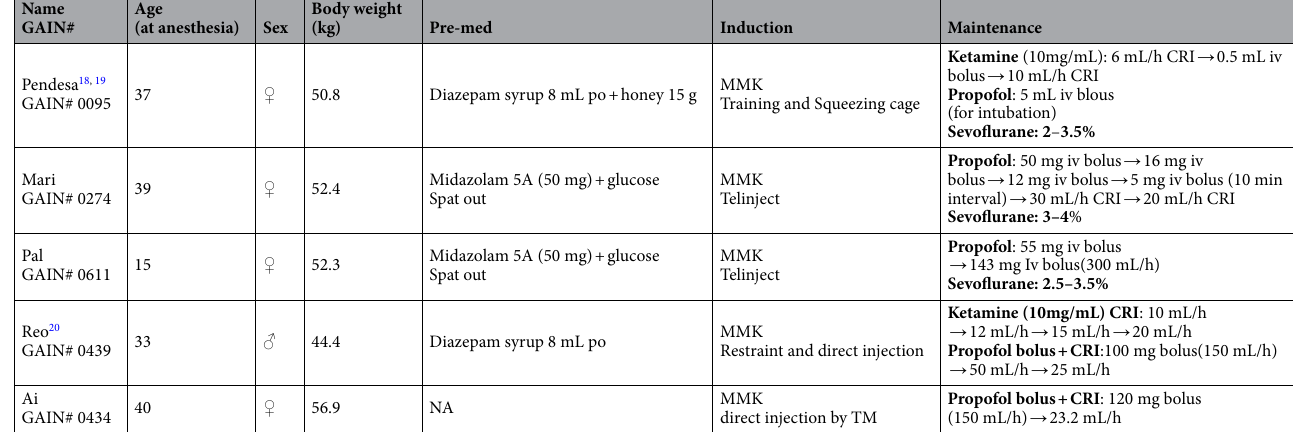
Table 1. Propofol administration in chimpanzees (2014–2016). MMK: Medetomidine 0.012 mg/ kg+Midazolam 0.12 mg/kg + Ketamine 3.5